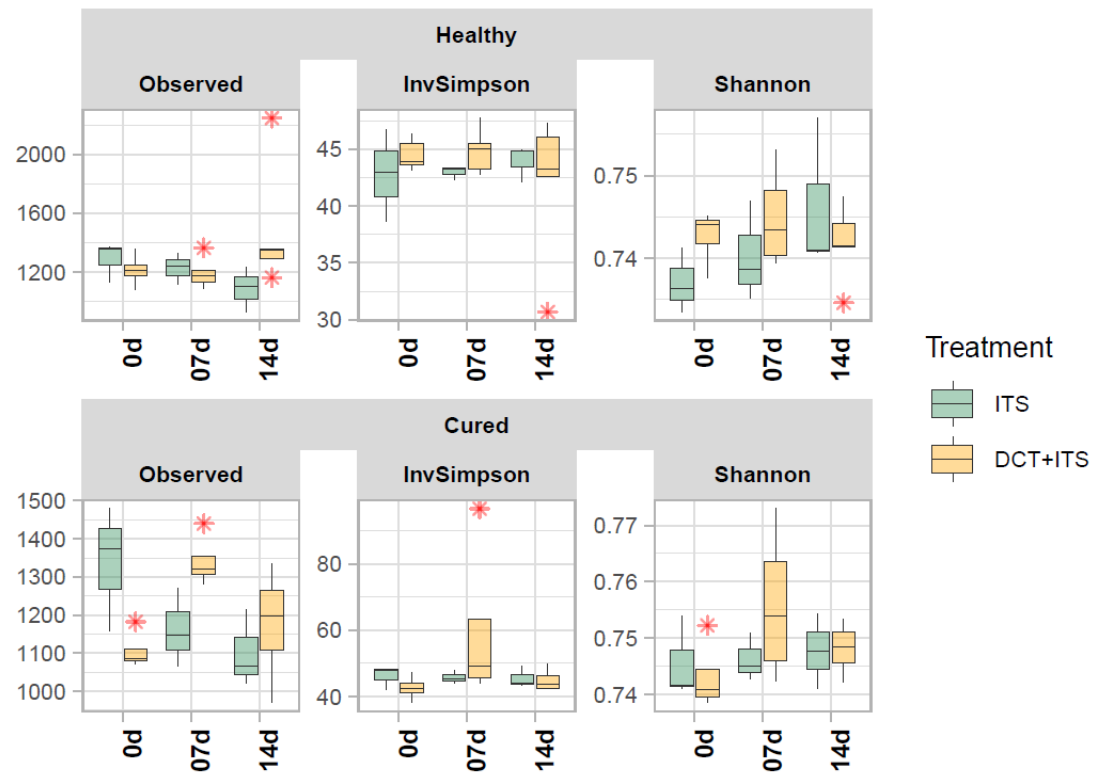
Figure 1. Alpha diversity of bacterial communities of the milk samples. Boxplots demonstrate the distribution of alpha diversity indices: number of observed ASVs (Observed), Shannon’s evenness (Shannon) and inverse of Simpson’s diversity (Invsimpson) for each sample grouped according to category (Healthy and Cured), treatment (ITS and DCT+ITS), and time of sampling (0 d: the day of drying-off, 7 d: 7 days after calving, and 14 d: 14 days after calving). Boxes represent the interquartile range (IQR) between the first(25th) and third quartiles (75th percentiles) whereas the horizontal line represents the median. Whiskers represent the lowest and highest values within 1.5 times the IQR from the first and third quartiles, respectively. The “ * ” represent outliers. Table 5. Beta diversity analysis: summary of the permutational multivariate analysis of variance